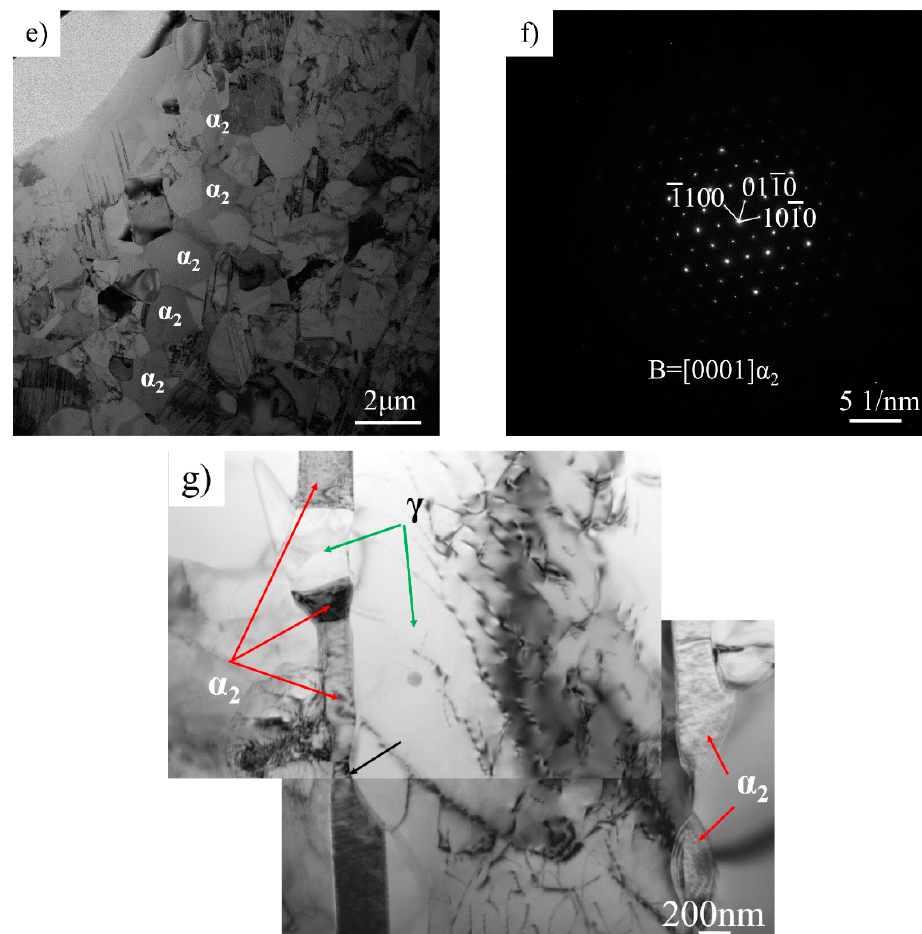
Figure 7. TEM analysis of α 2 lamellae in water-quenched Ti-44Al-8Nb-(W, B, Y) alloy after three rolling passes: ( a ) α 2 lamellae in a lamellar colony, ( b ) α 2 sub-grains in α 2 lamella, ( c ) grooving on the boundary of α 2 lamella, ( d ) γ grain on the boundary of α 2 lamellae, ( e ) equiaxed α 2 grains, ( f ) the diffraction pattern of α 2 grain, and ( g ) the final microstructure of the as-rolled alloy.